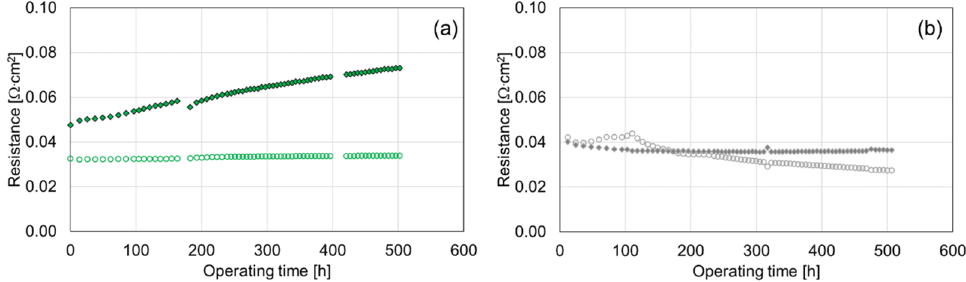
Figure 7. Ohmic (open circles) and polarization resistances (diamonds) during the electrolysis durability tests of ( a ) the ceramic SoA cell and ( b ) the MSC at 650 °C, − 0.25 A/cm 2 . Values were deduced from EIS.